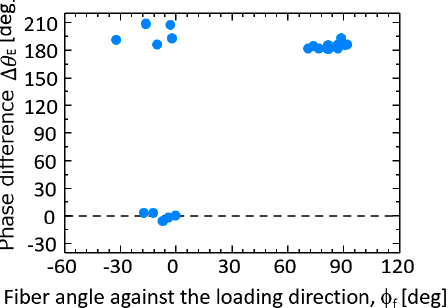
Figure 6. Relationship between phase difference ∆ θ E and fiber orientation angle φ f .: the phase difference ∆ θ E was measured for specimen in Figures 4 and 5 under σ max = 100 MPa and f =7